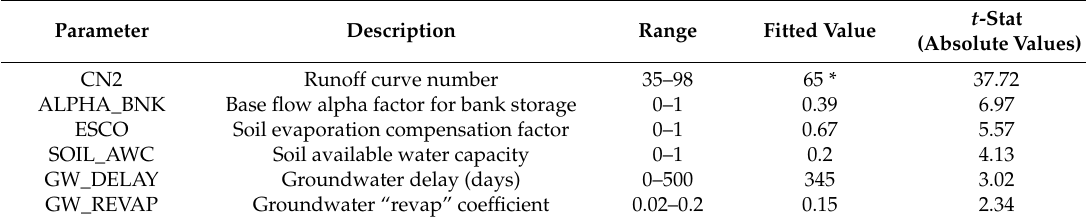
Table 3. Calibrated parameters for stream flow with sensitivity ranking ( t -stat).